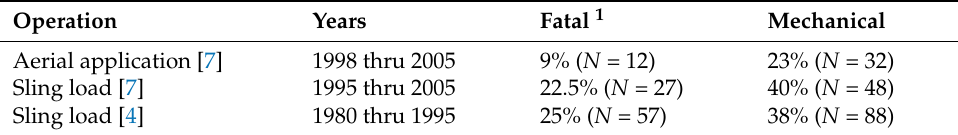
Table 1. Previous research on operations, fatalities, and mechanical failures. Operation Years Fatal 1